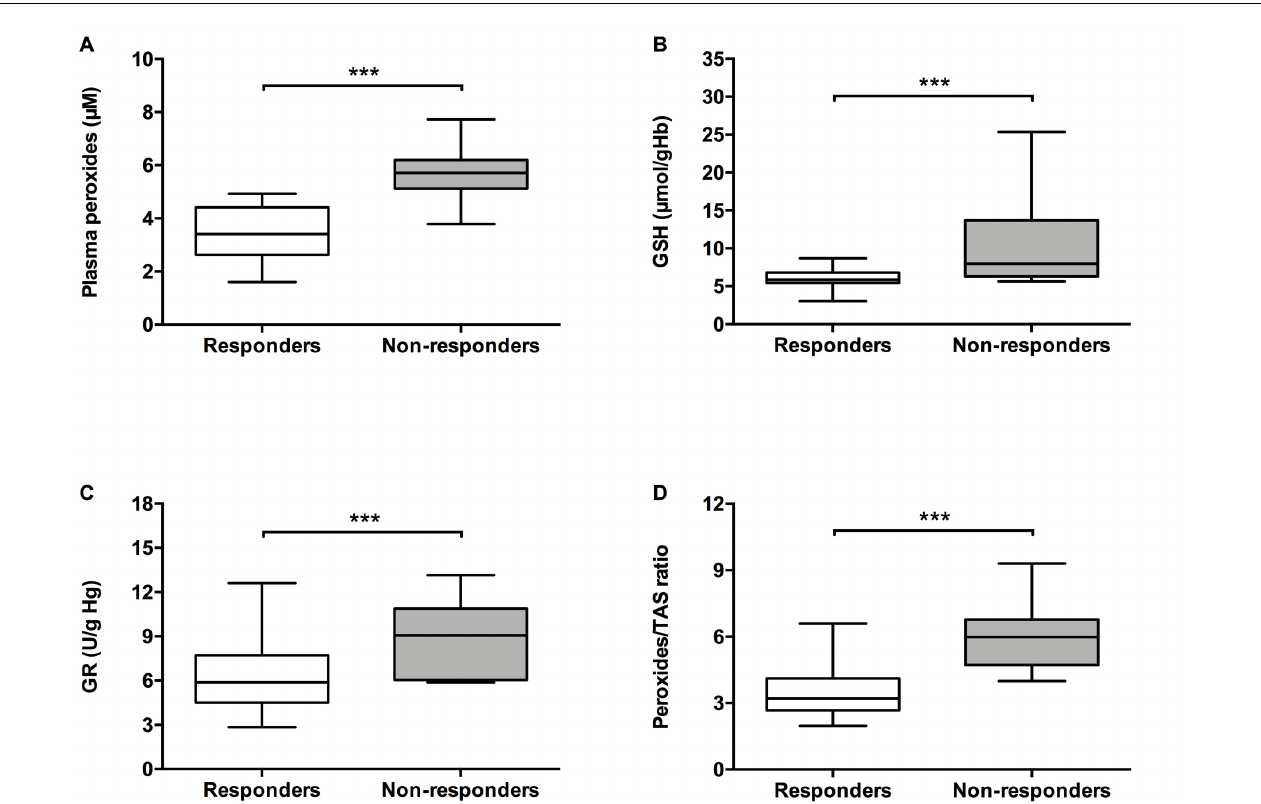
FIGURE 1 | Analysis of oxidative stress parameters in patients with myelodysplastic syndrome according to their response to ESA treatment. The following oxidative stress levels are represented: (A) plasmatic peroxides, (B) erythrocyte reduced glutathione (GSH), (C) erythrocyte glutathione reductase (GR), and (D) peroxides/total antioxidant status (TAS) ratio. *** p ≤ 0.001.